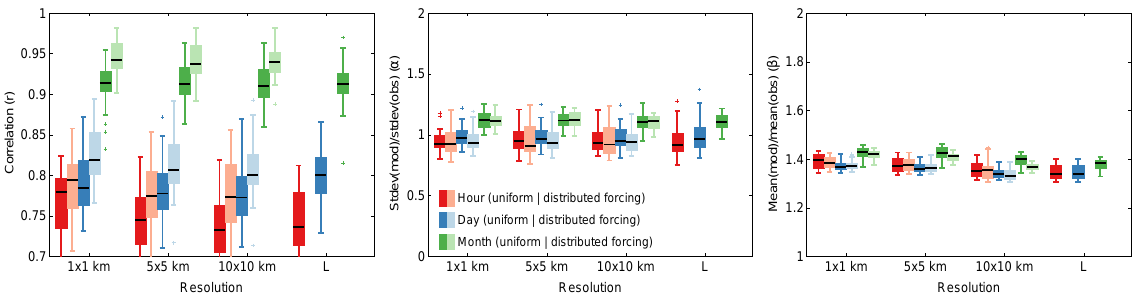
Figure 7. The model performance for the three separate components of the Kling–Gupta efficiency of the behavioural sets for different temporal and spatial resolutions. The left panel shows the correlation r , the middle panel the standard deviation of the model output divided by the standard deviation of the observations ( α ), and the right panel shows the mean of the model output divided by the mean of the observations ( β